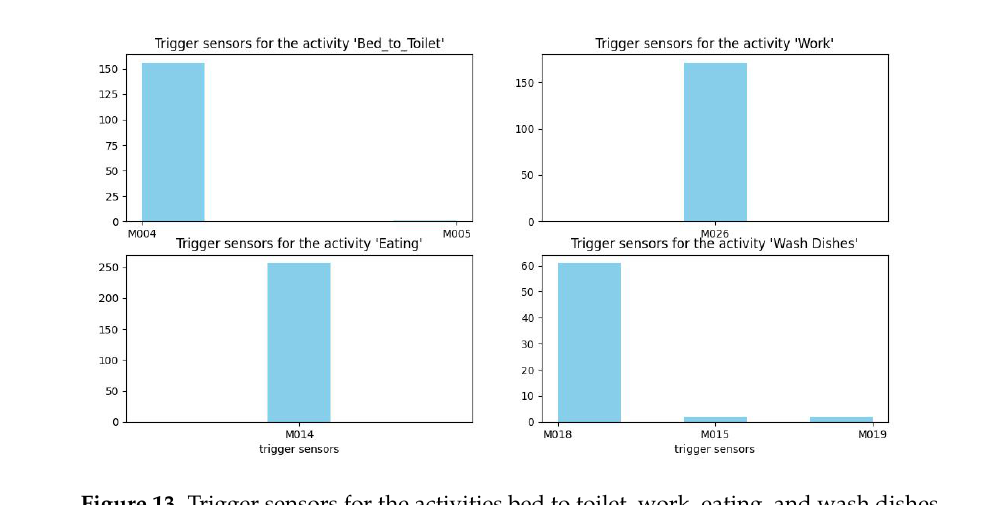
Figure 12. Trigger sensors for the activities sleeping, housekeeping, relaxing, and meal preparation.